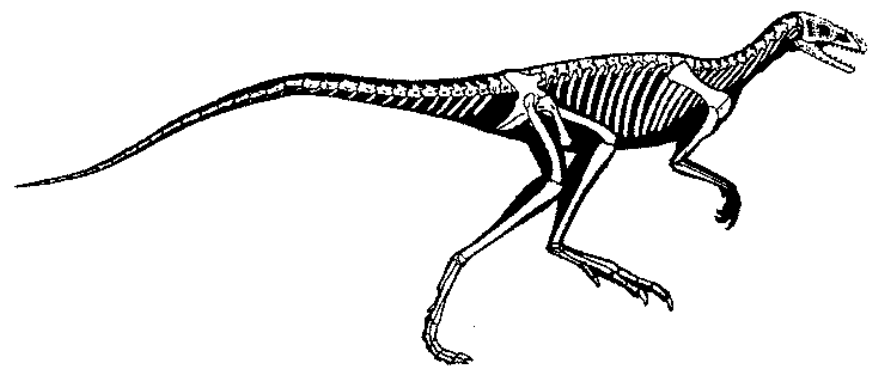
Fig. 6 – Schematic reconstruction of the skeleton of Marasuchus , a 1 m long basal pre-dinosaur ornithodirans (based on Sereno & Arcucci